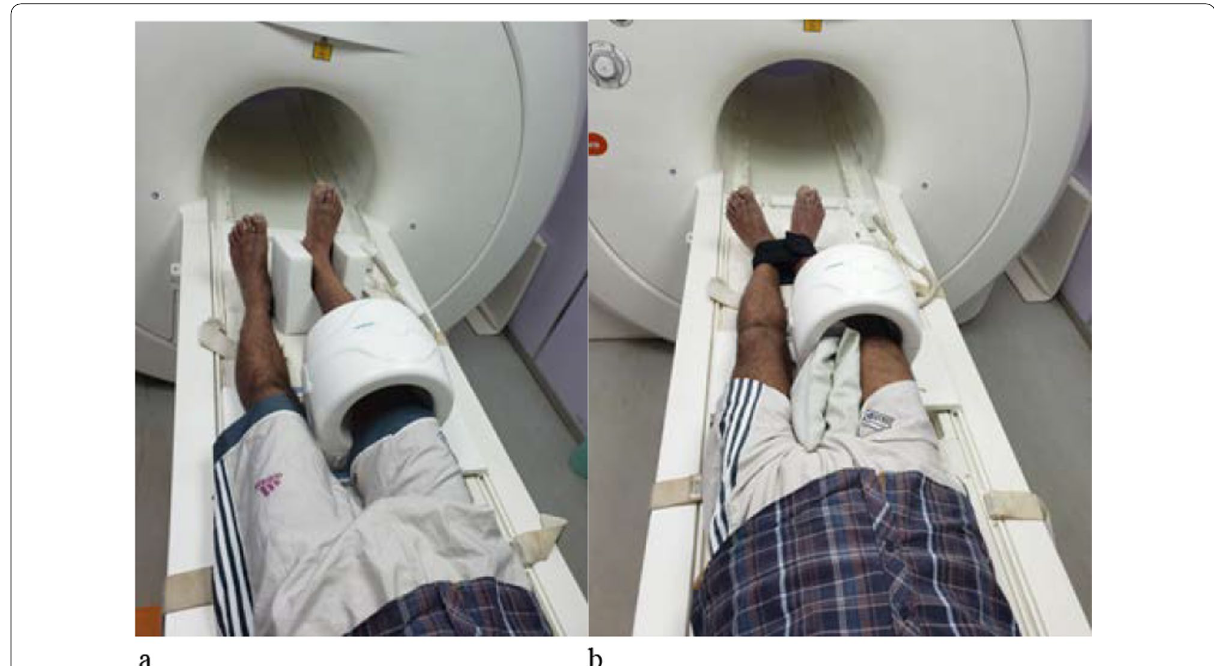
Fig. 2 Patient conventional position (pre‑varus) ( a ). Varus stress position technique ( b